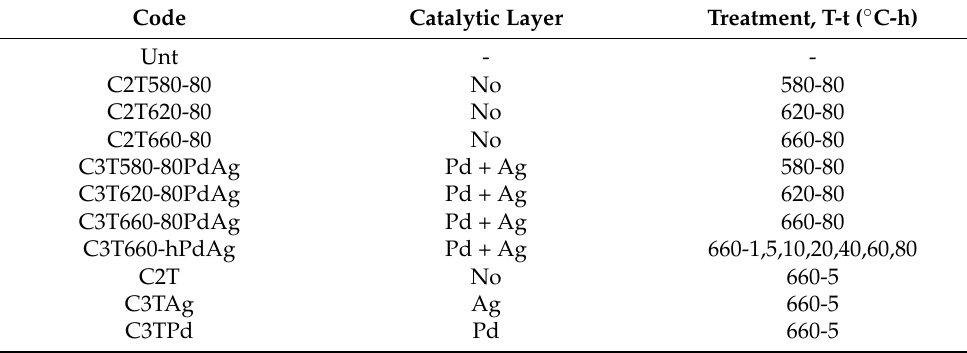
Table 1. Treatment conditions for the coded